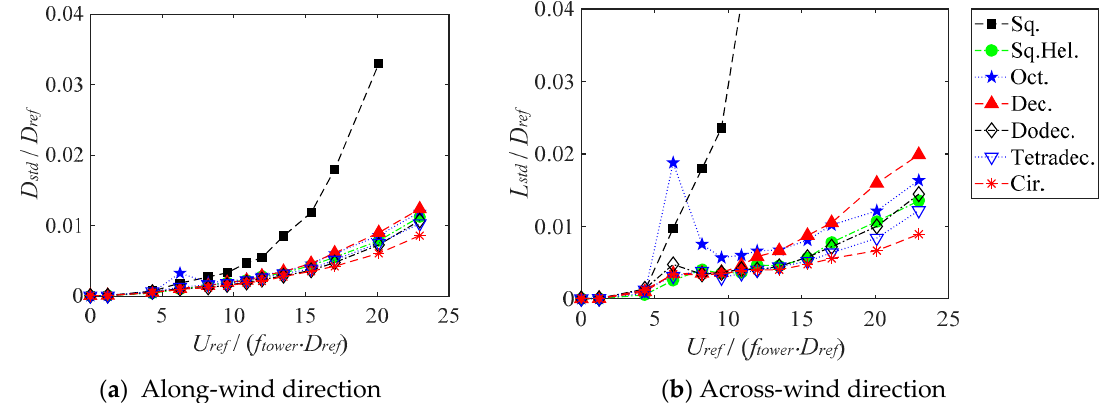
Figure 5. Fluctuating displacements for tower-only cases [15].